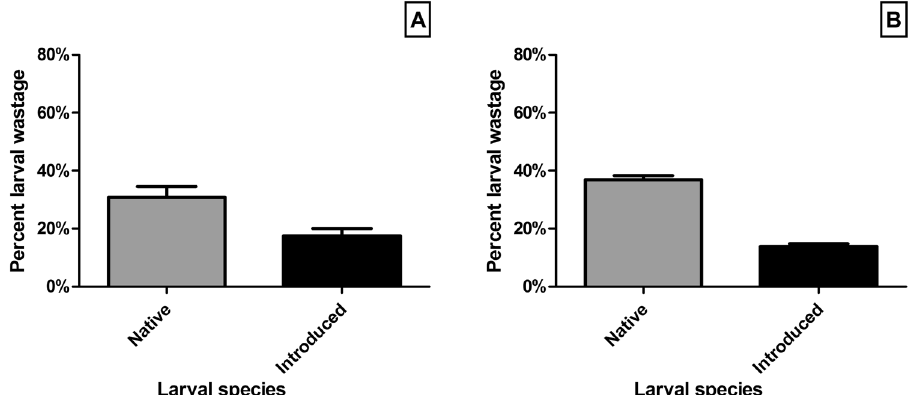
Figure 4. Larval wastage (non-settling larvae) for native and introduced larval (dose) species in the presence of ( A ) control and ( B ) test basibiont substrates ( C. foliata ; C. bispinata ; C. pallasiana ; S. unicornis ; W. subtorquata ) ( ±